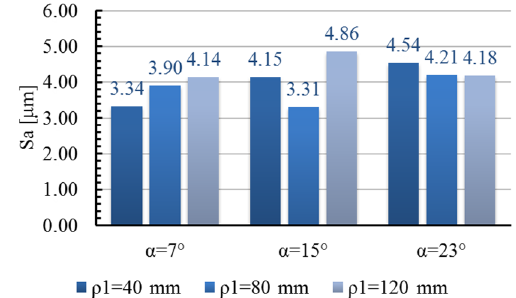
Figure 21. Statement of the measurement results of the parameter Sa of the concave surface of the turbine blade.